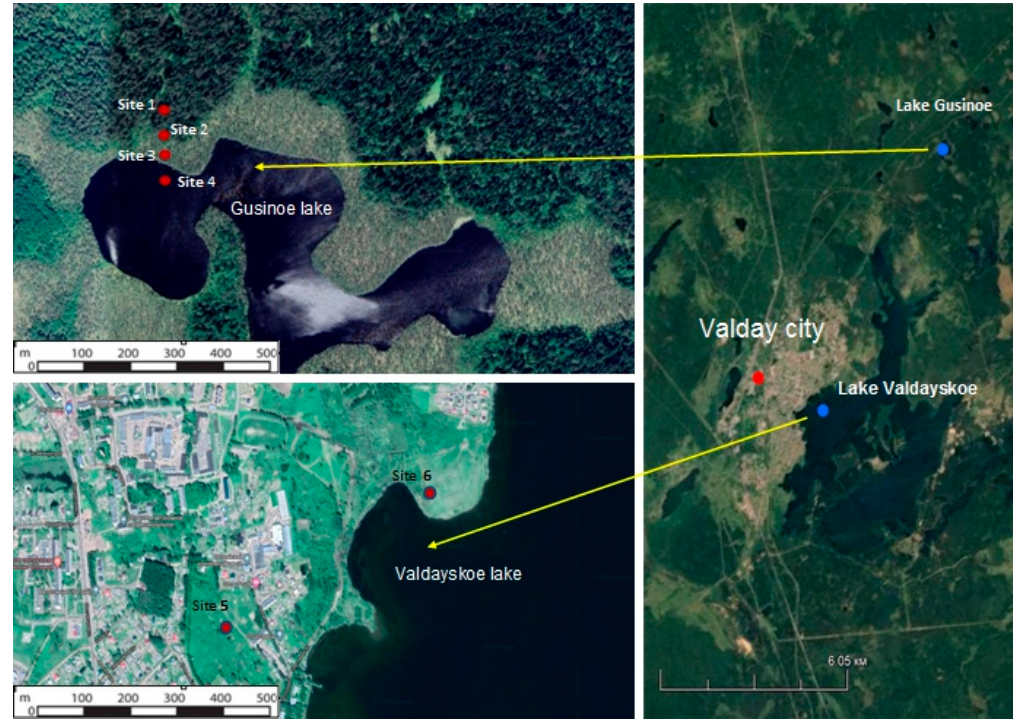
Figure 1. Sampling points and filtering equipment.